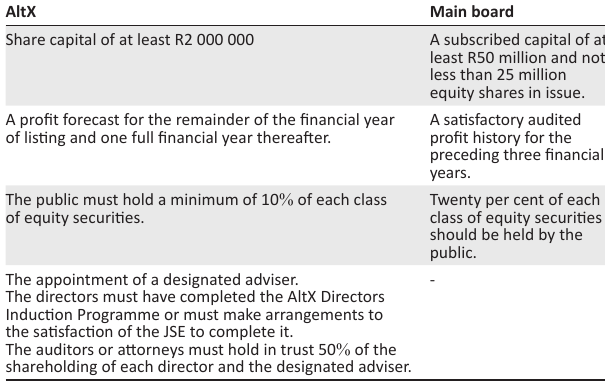
TABLE 1: A comparison of listing criteria of the Alternative Exchange and the Johannesburg Securities Exchange’s main board.